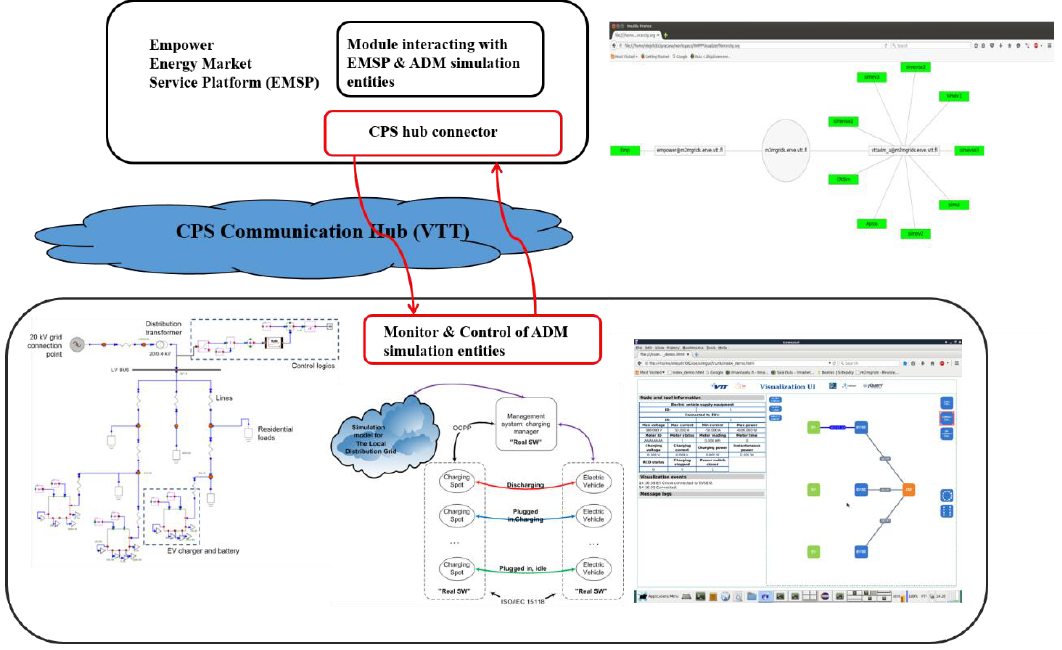
Figure 21. Experimental system of the automated dynamic microgrids. EMSP, energy market service platform; ADM, automated dynamic microgrid.